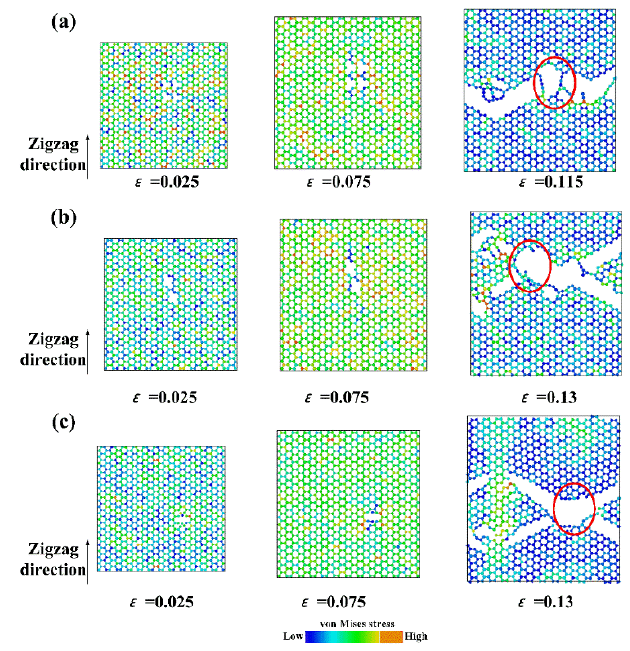
Figure 10. The fracture process of Gr containing: ( a ) SV; ( b ) DV; and ( c ) SW. The red ring indicates the location of defect.